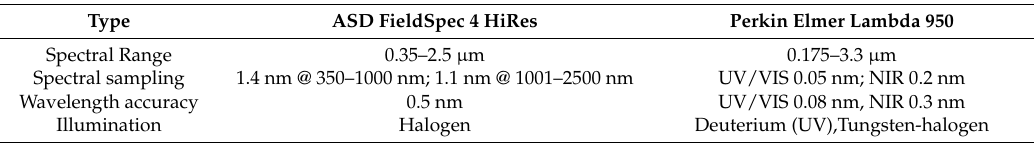
Table 2. Specifications of ASD 4 FieldSpec HiRes (from manufacturer online resource https:// www.asdi.com/products-and-services/fieldspec-spectroradiometers/fieldspec-4-hi-res accessed on 14 June 2017) and PerkinElmer Lambda 950